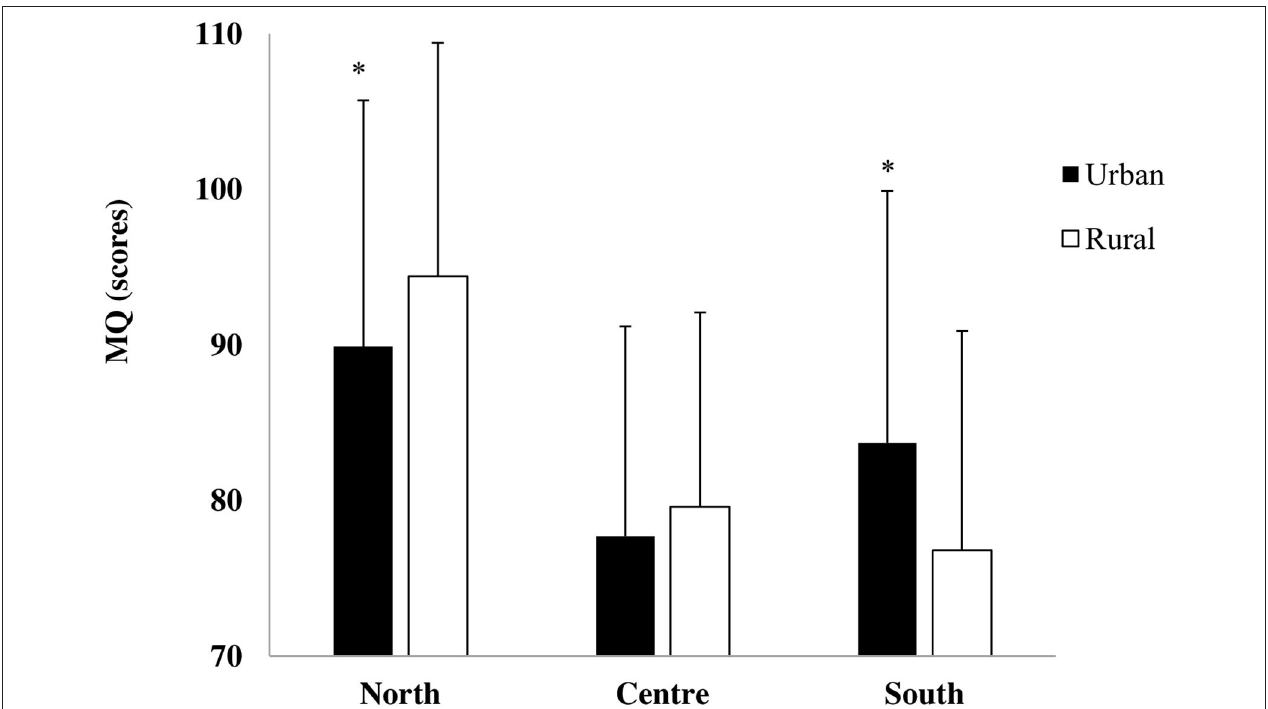
FIGURE 2 | Motor quotient (MQ) in urban and rural children of the North, Center, and South of Italy (* p = 0.0002 urban vs. rural).